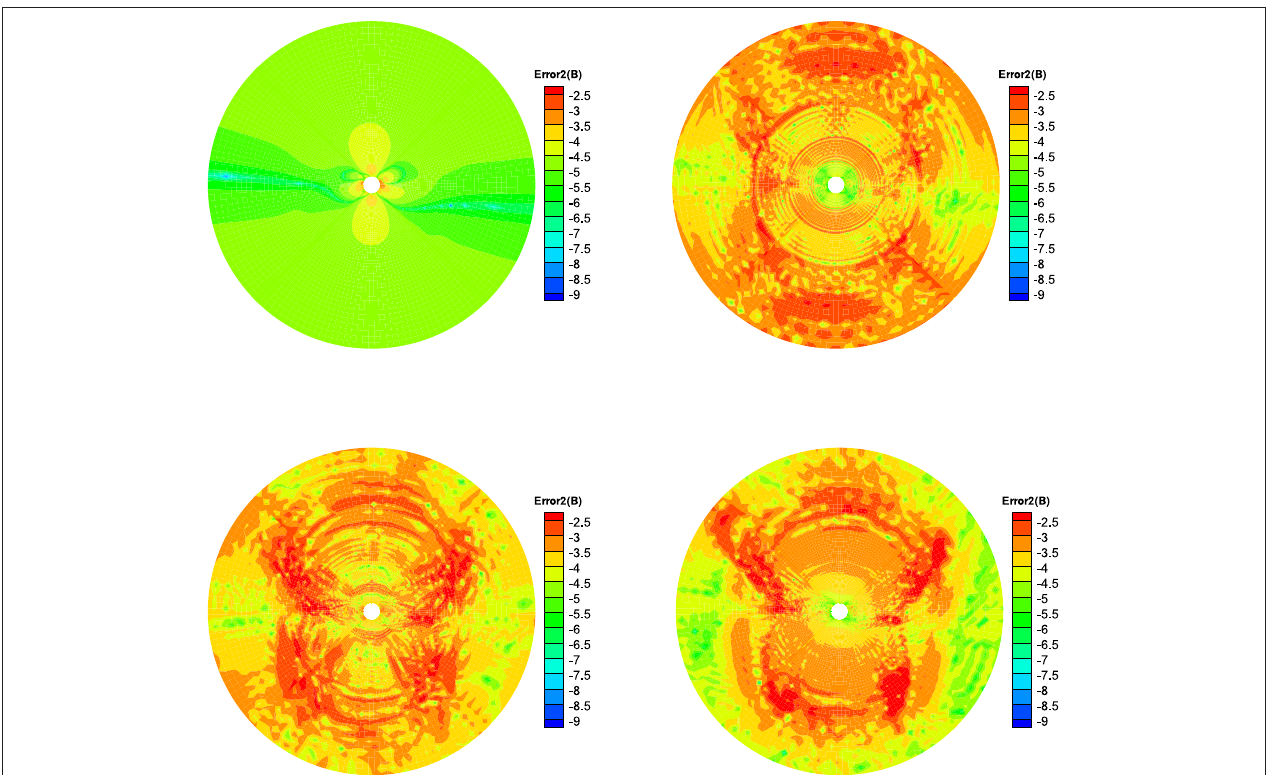
FIGURE 8 | The log 10 Error2 (B) in the calculation at t = 5h on the meridional plane of φ = 180 ◦ − 0 ◦ from 1 to 20 R s , the results from CT method (left) and diffusive method (right) are displayed in the top row, the bottom row is obtained from the projection method (left) and GLM method (right).